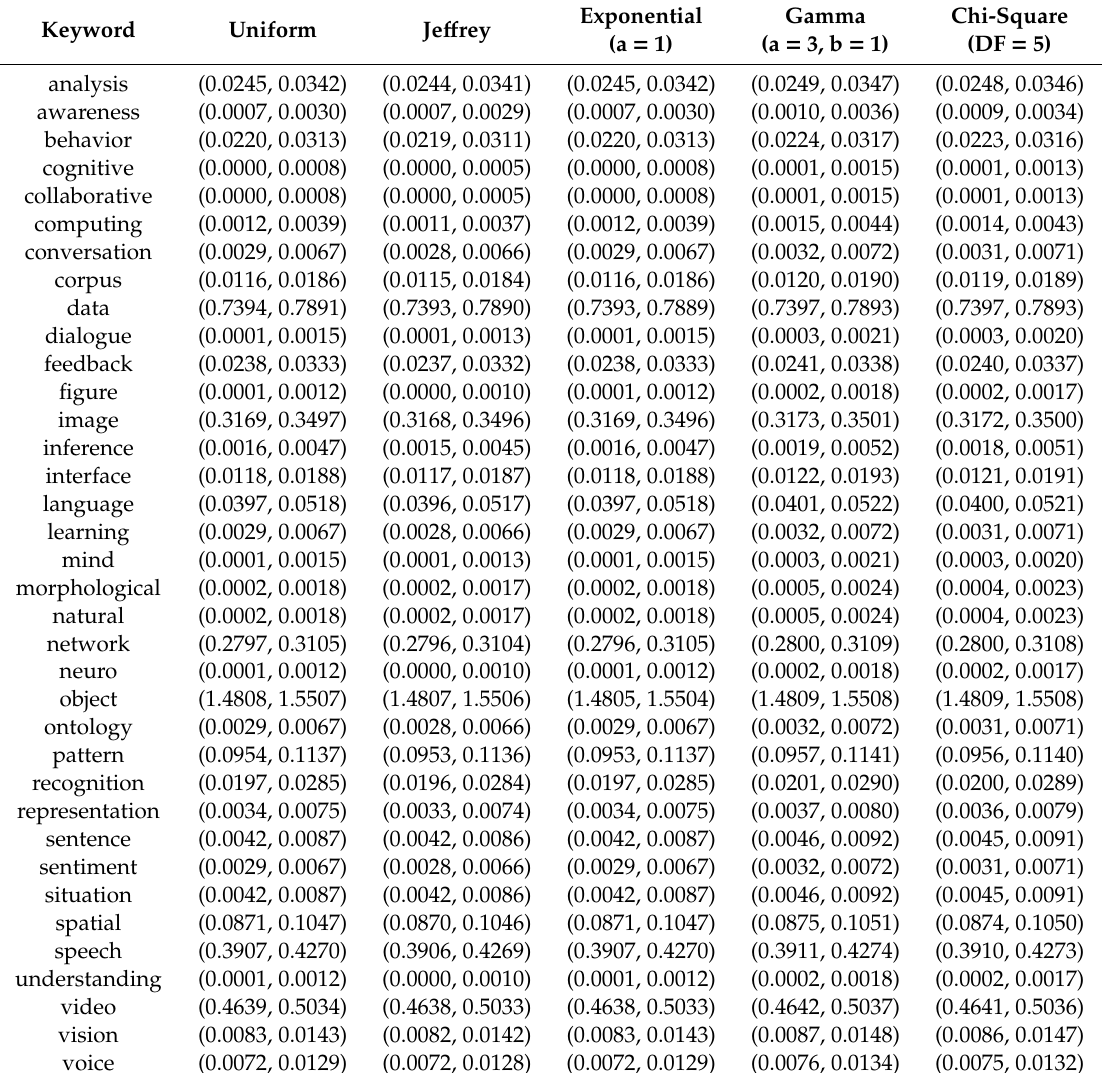
Table 6. Bayesian prediction intervals: